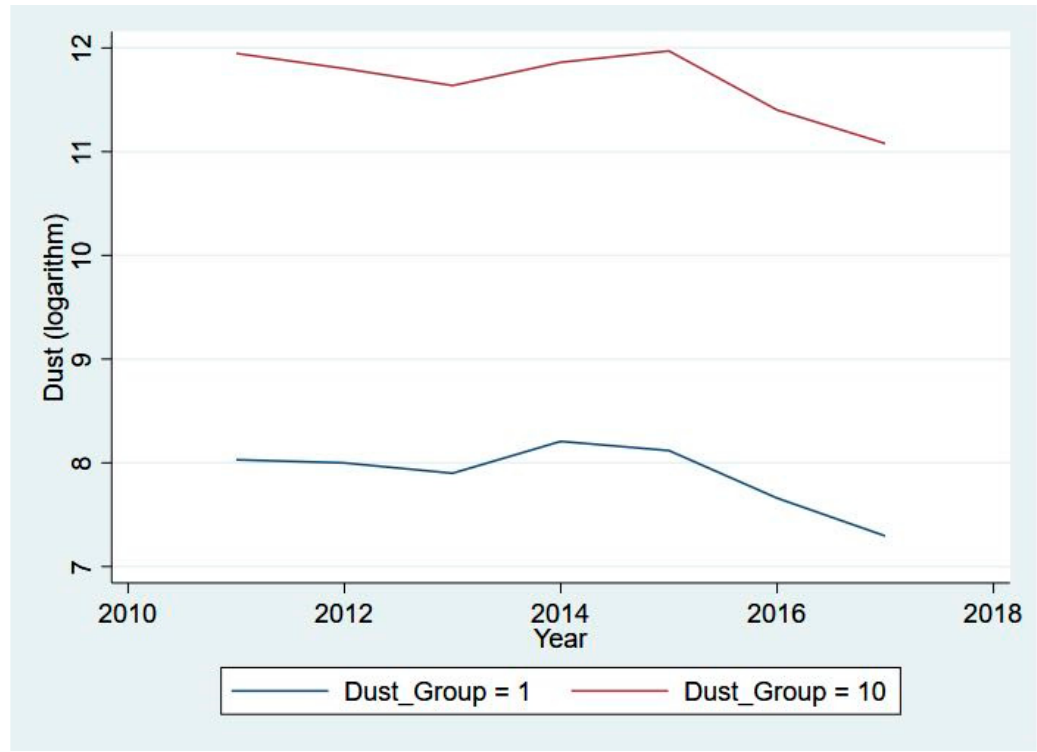
Figure 4. Dust level for 1st and 10th groups, 2011–2017.